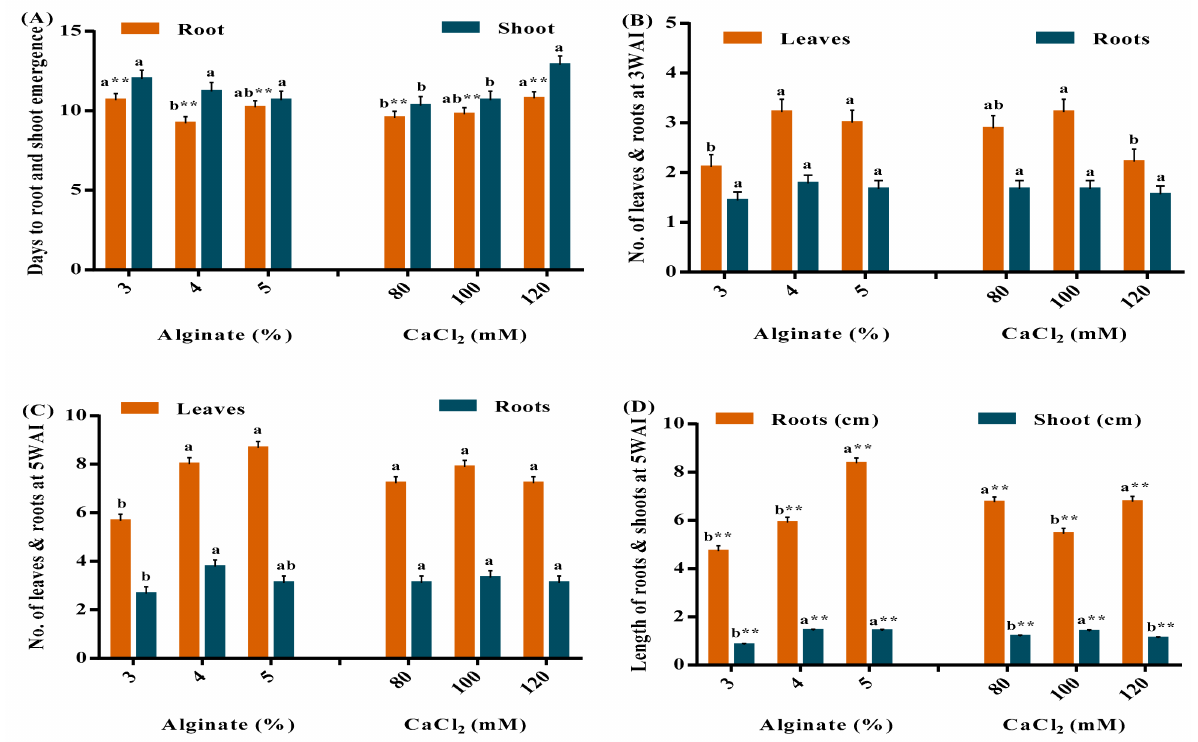
Figure 1. Effect of sodium alginate and CaCl 2 concentration on encapsulated vegetable sweet potato ( Ipomoea batatas L) nodes, i.e., number of days to root and shoot emergence ( A ), number of leaves and roots at three weeks after inoculation into Murashige and Skoog (MS) medium ( B ), number of leaves and roots at five weeks after inoculation into MS medium ( C ), and length of roots and shoot at five weeks after inoculation into MS medium ( D ); (**) indicates significant interaction between the evaluated parameter at 1% probability levels. Means with a different letter(s) within the bars differ significantly at a 5% probability level using